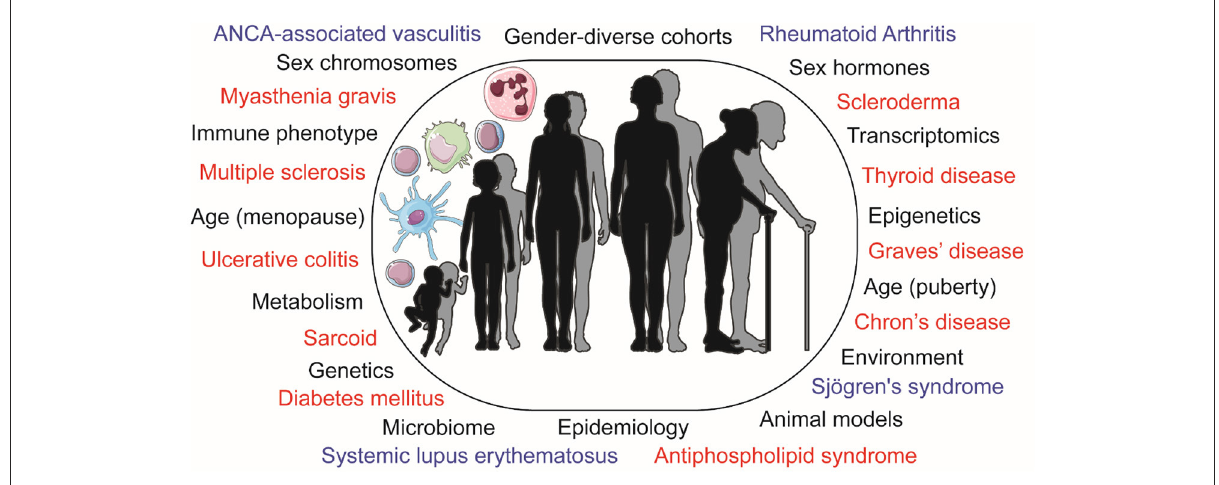
FIGURE1 Schematic representation of the differences observed in immunology and autoimmune disease risk by sex and age, displaying pathophysiological influences and research methods used to explore these in black. Autoimmune diseases that present with a sex bias are displayed in blue (for those covered in this article) or red. ANCA, anti-neutrophil cytoplasmic